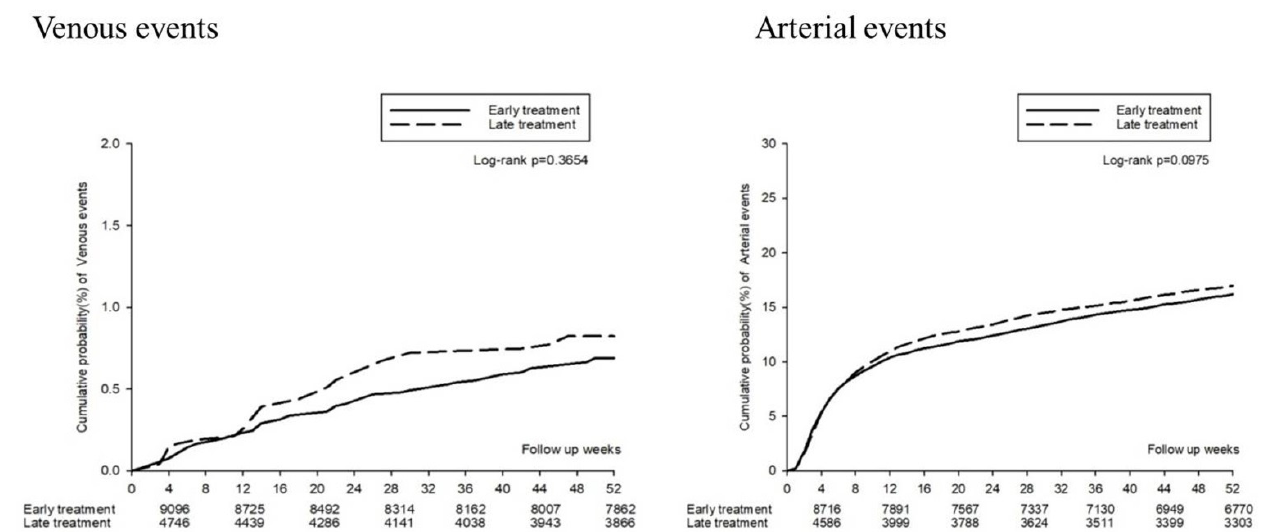
Figure 5. Flowchart of patient selection.